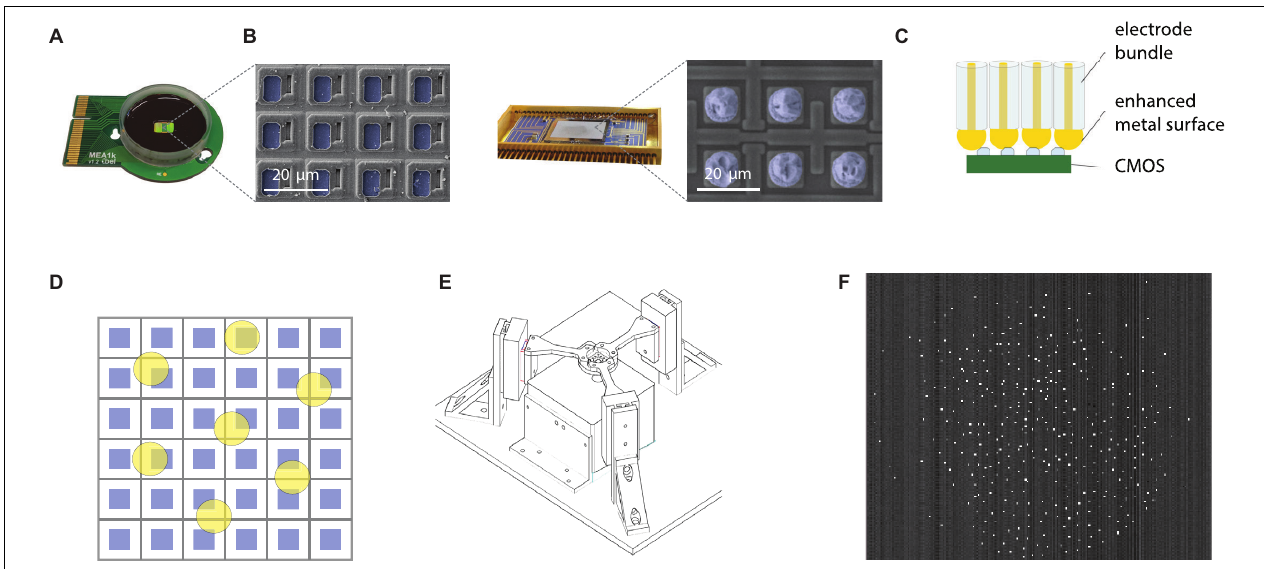
FIGURE 3 | Scalable direct bonding of electrodes to CMOS pixels. (A) Mea1k, a high-density, high signal-to-noise, switch-matrix based MEA chip (Müller et al., 2015). Inset: SEM of the chip surface. Blue pseudo-colored areas denote the active Pt recording sites. (B) Commercial IR sensors provide another class of high pixel-count CMOS amplifier array, capable of sampling from > 10 5 pixels at rates of several kHz (here: Xenics Cheetah 640CL, Neys et al., 2008). Blue pseudocolor in the SEM image indicates Indium bumps on the amplifier input sites. (C) Direct contacting of electrode bundles to the conductive pixels is a highly scalable strategy to electrically interface bundles to electrode arrays. Increasing the size of the contacting metal surface of the microwires can be achieved in multiple ways and can enhance contact quality (e.g., Figure 2C ). (D) High yield of contacts can be achieved without the alignment of electrode cores (yellow) and pixel recording areas (blue) by using sufficient spacing and large diameter electrode cores. (E) Alignment of the recording bundle and the flat CMOS array was achieved by a three-arm force-sensitive micromanipulator system. (F) A wire bundle of 200 electrodes connected to the amplifier array of an IR CMOS sensor. Bright pixels indicate connected electrodes, due to a small offset between the animal and the reference of the pixel